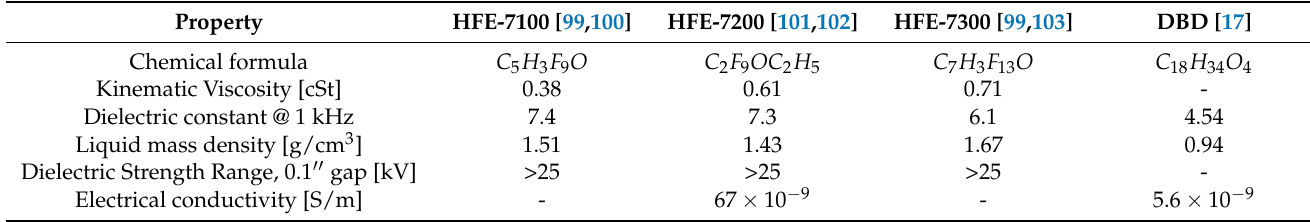
Table 5. HFE-7100 and HFE-7300